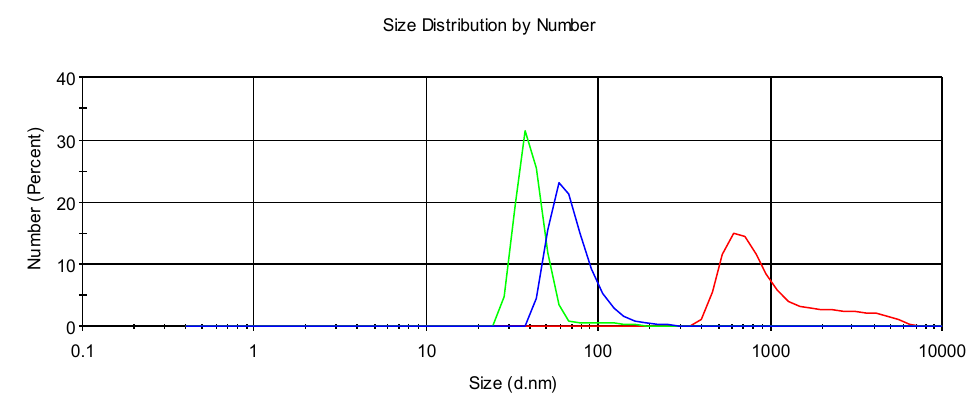
Figure 6. Particle number weighted size distribution of CG-NioP (green), CG-NioP–mucin mixture (blue), and mucin solution (red).